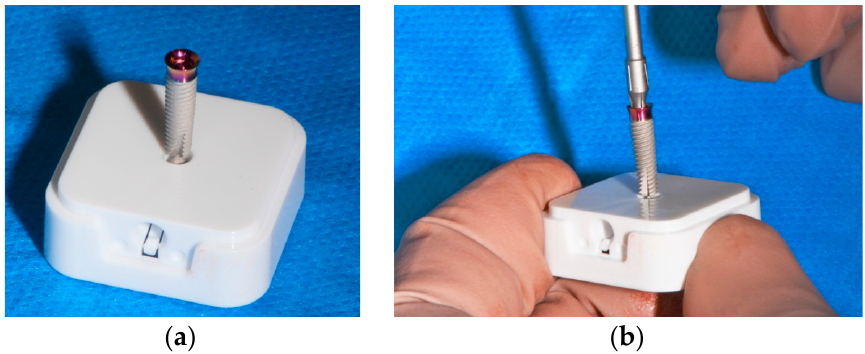
Figure 7. ( a ) Control of the position with the implant direction indicator; ( b ) control of the position with the implant direction indicator.